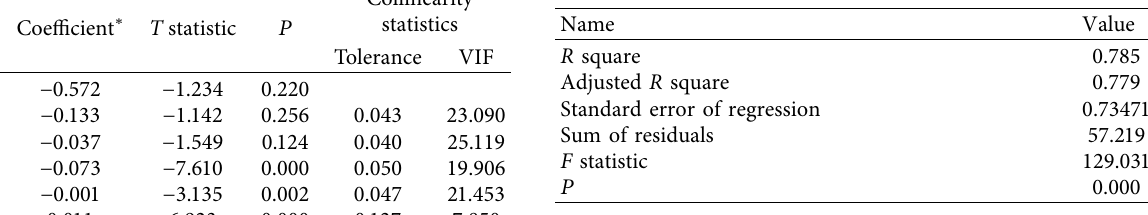
Table 4: Significance of coefficients (acceleration peaks included). Table 5: Statistics of the adjusted quadratic models (acceleration peaks included).